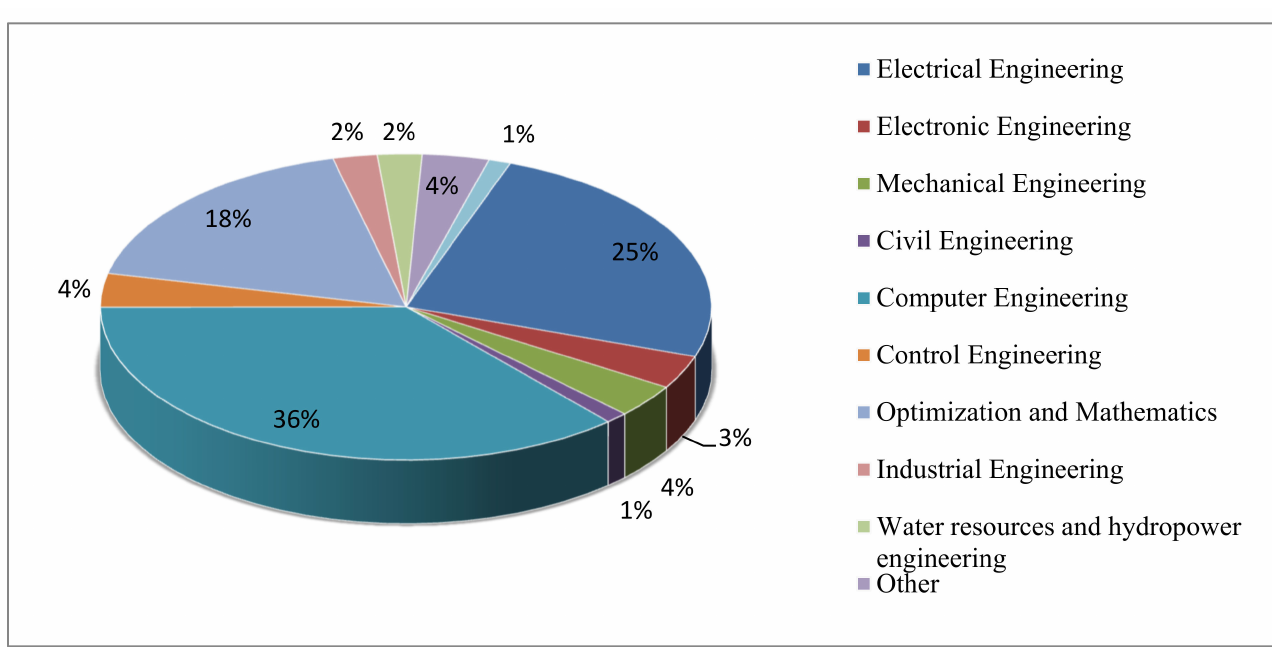
Figure 11 indicates the proportion of published articles in various fields of studies us- ing HS and fuzzy. Likewise, Figure 12 indicates the number of articles written depending on the mixture of the various fields of analysis. In accordance with the statistical results shown in Figures 11 and 12, majors in “computer engineering”, “electrical engineering”, and “optimization & mathematics” represent a higher percentage of the presented